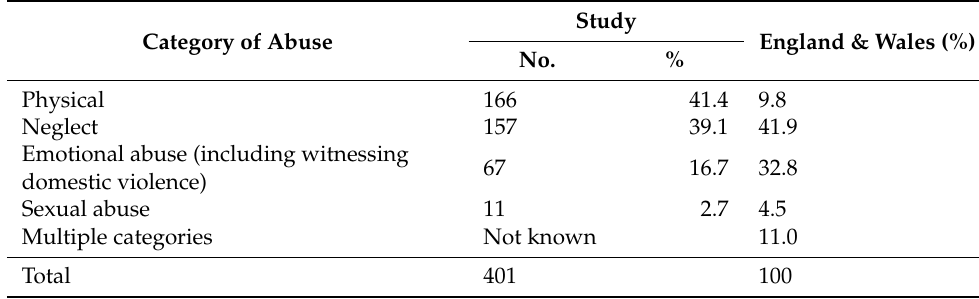
Table 5. Categories of abuse ( n =